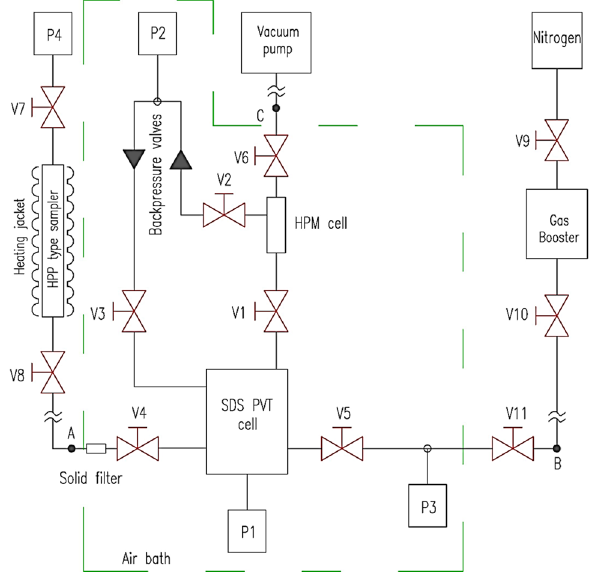
Fig. 1 Schematic diagram of the laboratory unit. (P)—pump, (V)— valve, (A, B, C)—connection points for the external equipment (Struchkov and Roschin